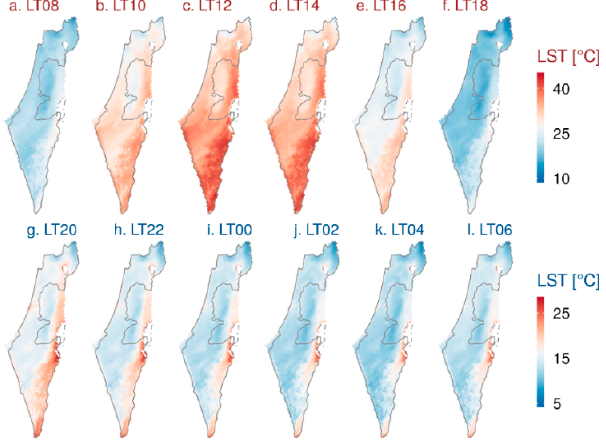
Figure 9. Spatial pattern of multi-annual mean hourly SEVIRI Ts at 2-h intervals imputed by GAM in Stage 1.